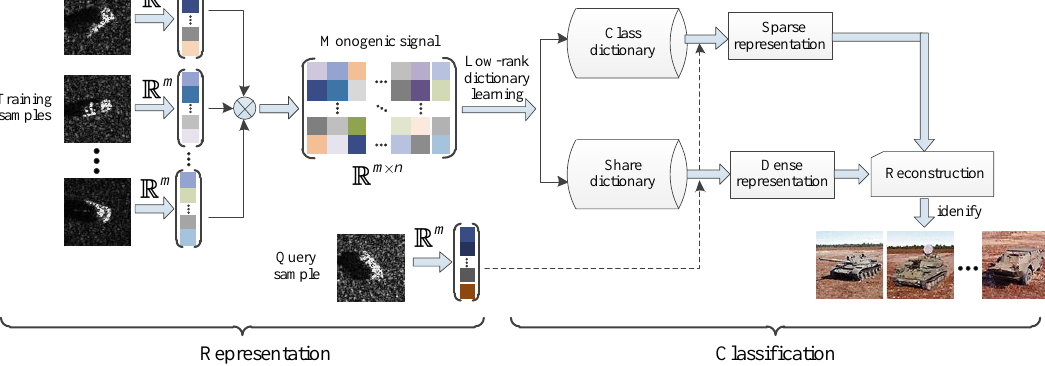
Figure 1. Block diagram of the proposed strategy for the target recognition procedure. The proposed strategy consists of two phases: representation and classification. The first phase describes training with monogenic signal samples. The second phase learns the class dictionary and the shared dictionary to encode the query sample as a joint sparse and dense representation. The decision is made by evaluating the class with the minimal reconstruction